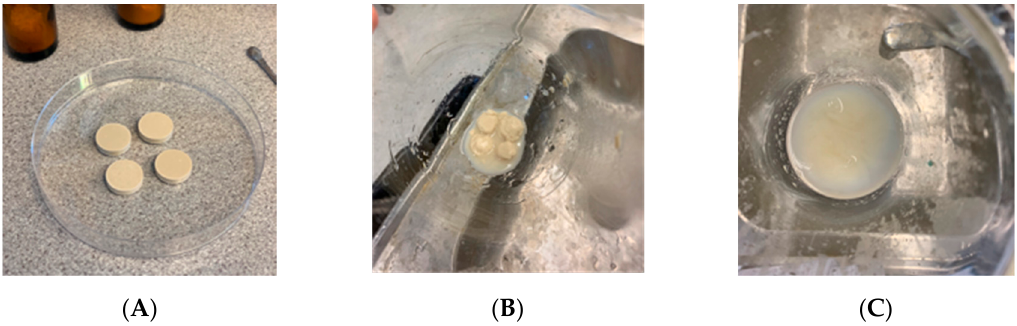
Figure 4. Pictures of formulated IBU-CLAD tablets before ( A ) and after 3 h of dissolution experiments ( B ) without AcDiSol and with ( C ) AcDiSol.